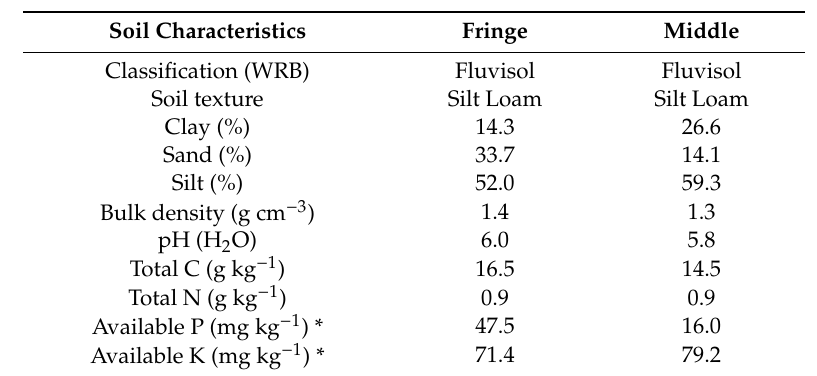
Table 1. Selected physical and chemical properties of the experimental topsoil (0–20 cm) in Kilombero floodplain at the onset of the experiment in November